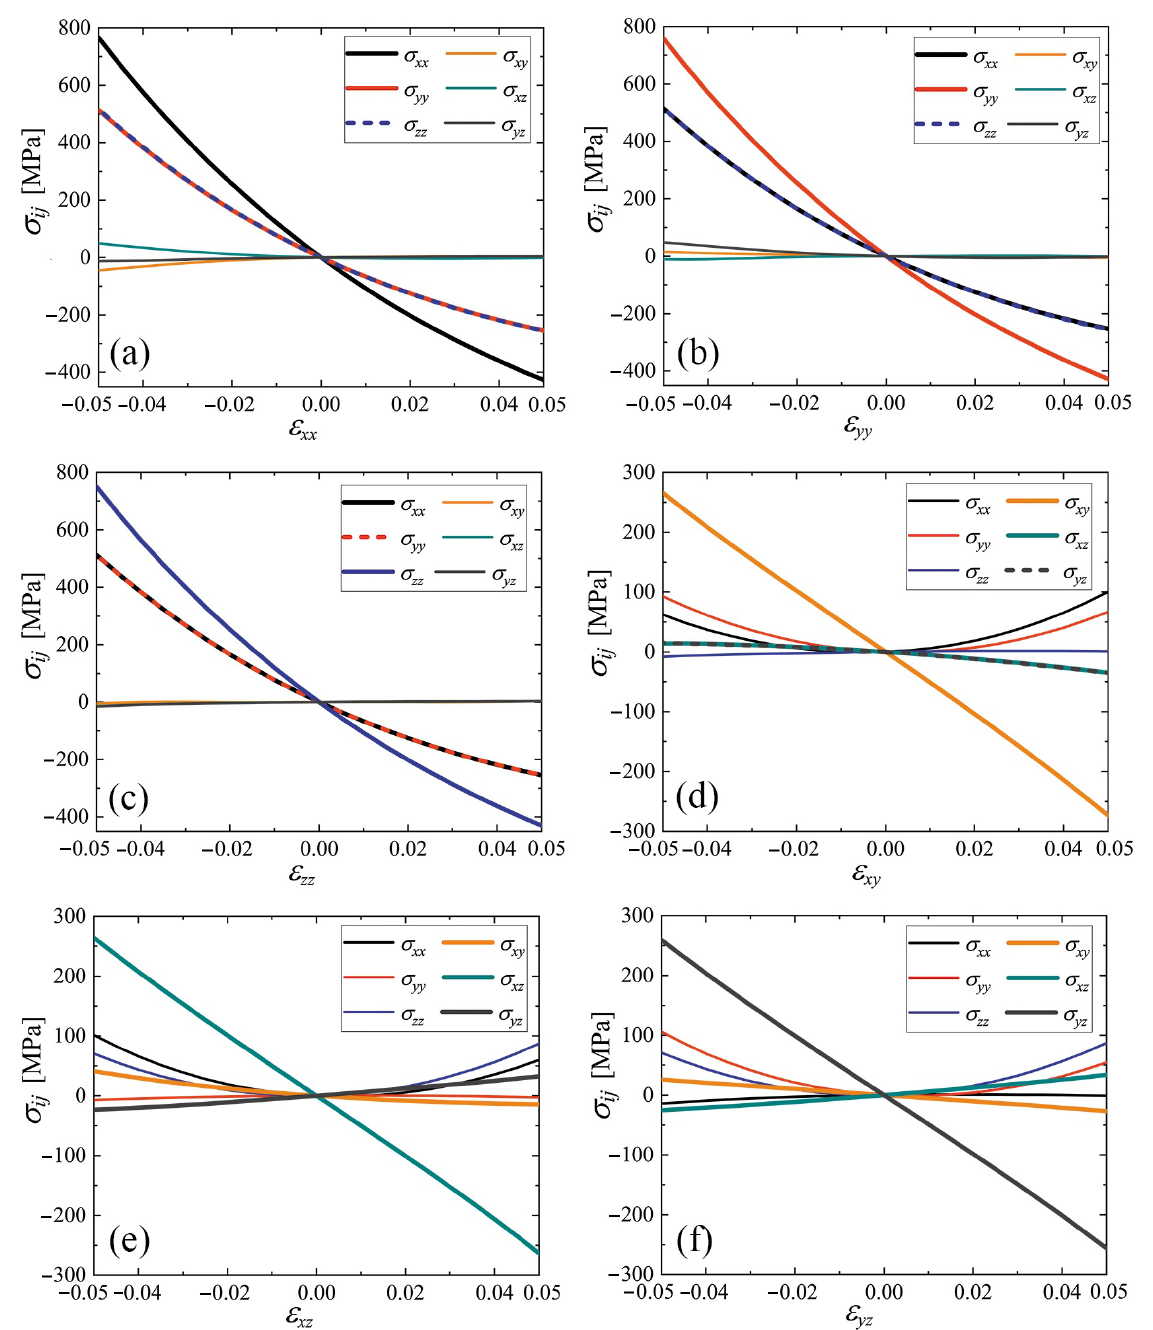
Figure 6. Stress–strain curves for triclinic cubene crystal. Only one component of the strain tensor is varied, the rest are equal to zero. Line colors are the same as in Figure 5. Panels ( a – f ) correspond to changing ε xx to ε yz ,